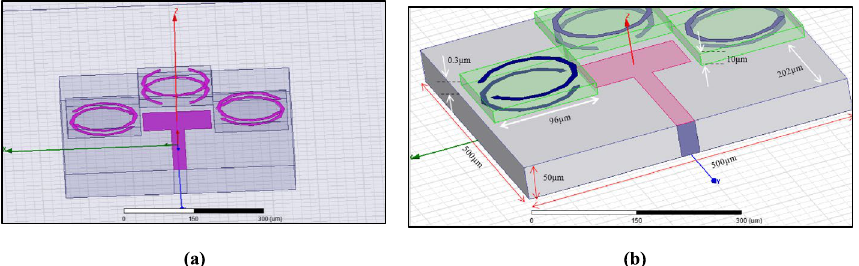
Fig. 10 DBC-SRR loaded horizontally microstrip patch antenna. a Model in HFSS. b Dimensions of proposed